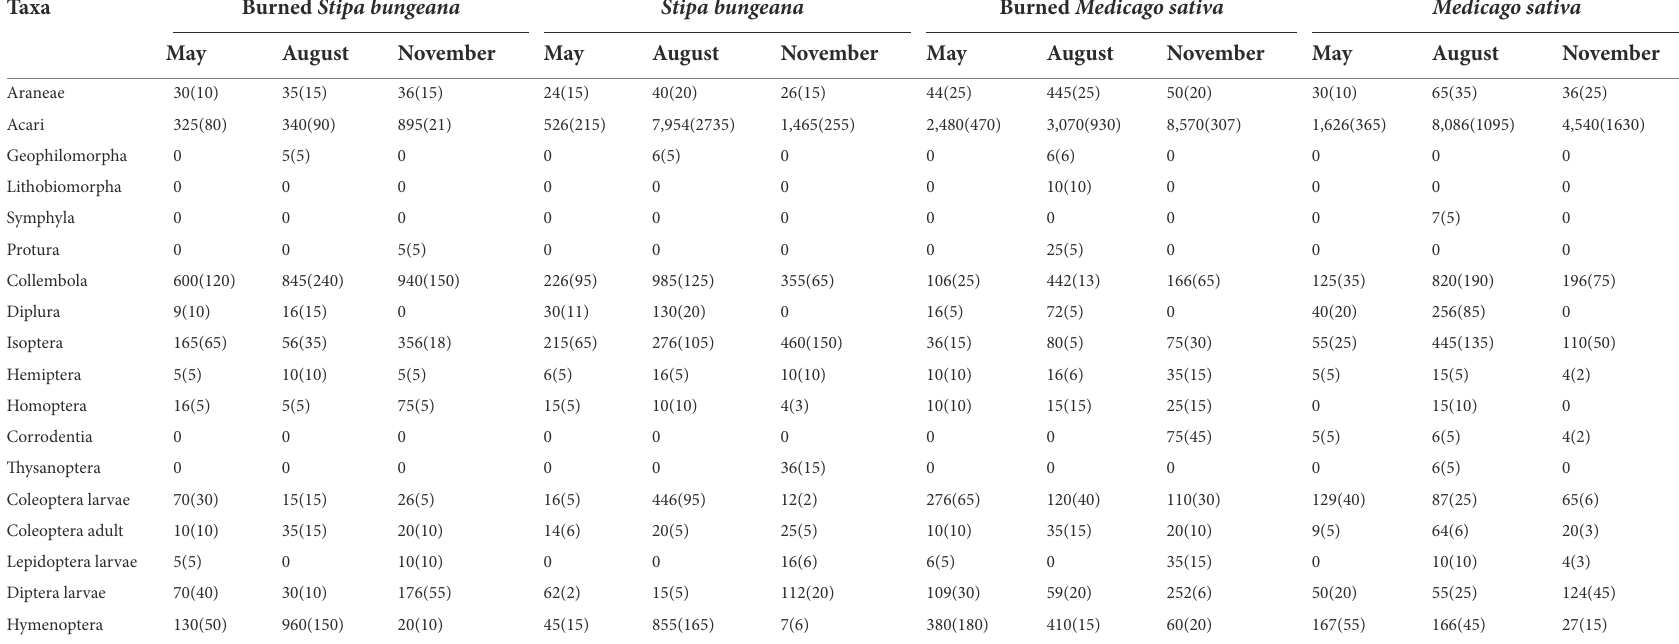
TABLE 1 Soil fauna abundance (mean individuals m − 2 ± SE) as influenced by the different habitats and sampling